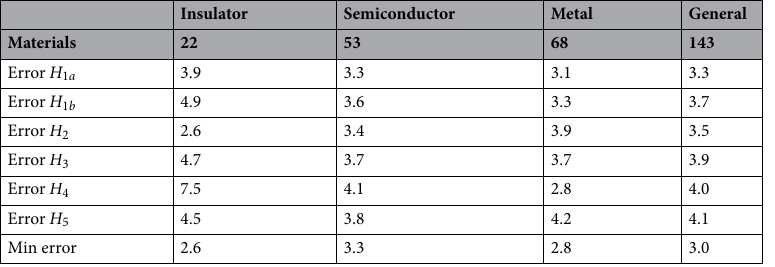
Table 2. Hardness MAE (GPa) for various materials classified by bandgap (Insulators, Semiconductors and Metals), using six different semi-empirical relations. Materials specifies the number of compounds considered in each classification. The Min Error value corresponds to the method that minimizes the error in each case.